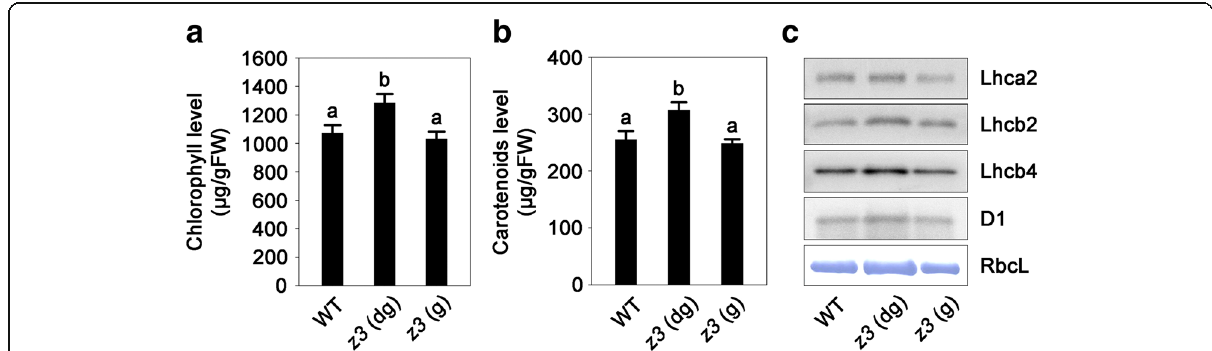
Fig. 2 Characterization of photosynthetic pigments and proteins in the leaves of the z3 mutant. a – b Chlorophyll concentrations ( a ) and carotenoids concentrations ( b ) in the leaves of the WT and the z3 mutant. Chlorophyll and carotenoids were extracted from the second leaves of plants at 110 DAS grown under natural long day conditions. Means and SD were obtained from five biological replicates. The letters a and b on the bars denote that they are significantly different at the 1% level according to the Duncan ’ s multiple range test. c Immunoblot analysis of chloroplast proteins. Total protein was extracted from the second leaves of 110-day-old plants, and extracts were subjected to SDS-PAGE. Antibodies against Lhca2, Lhcb2, Lhcb4, and D1 were used for detection, and the Rubisco large subunit (RbcL) was detected by Coomassie brilliant blue staining. FW, fresh weight; WT, wild type; z3 (dg), dark-green sectors of the z3 mutant leaves; z3 (g), green sectors of the z3 mutant